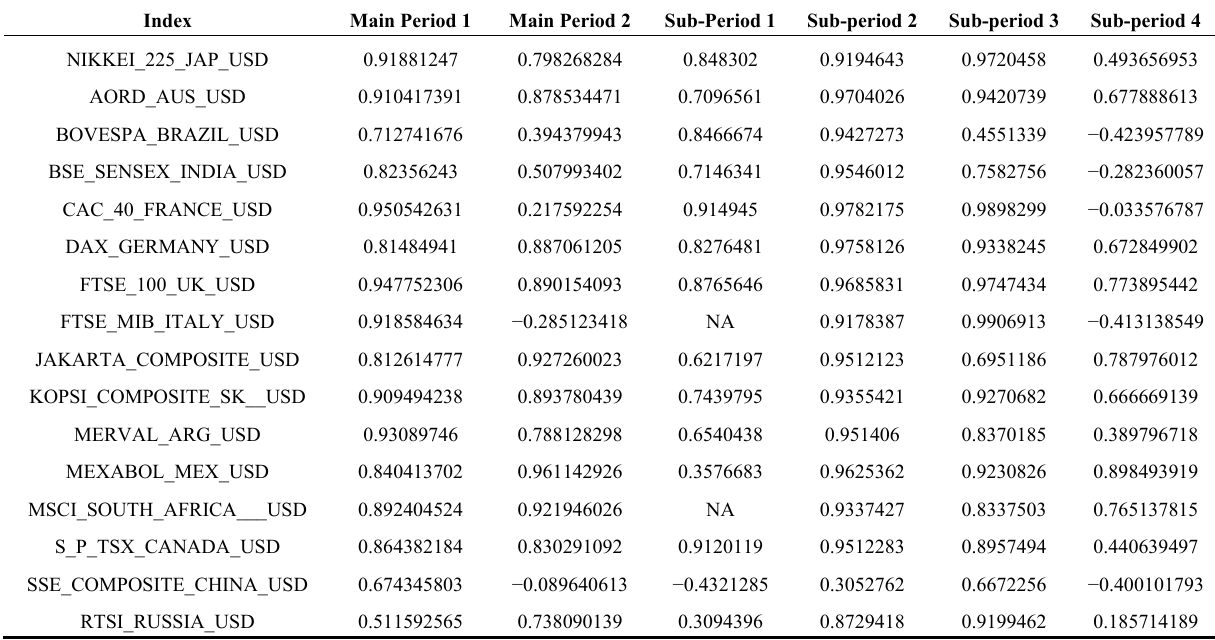
Table 2. Pearson’s Correlation between S&P 500 and Individual G-20